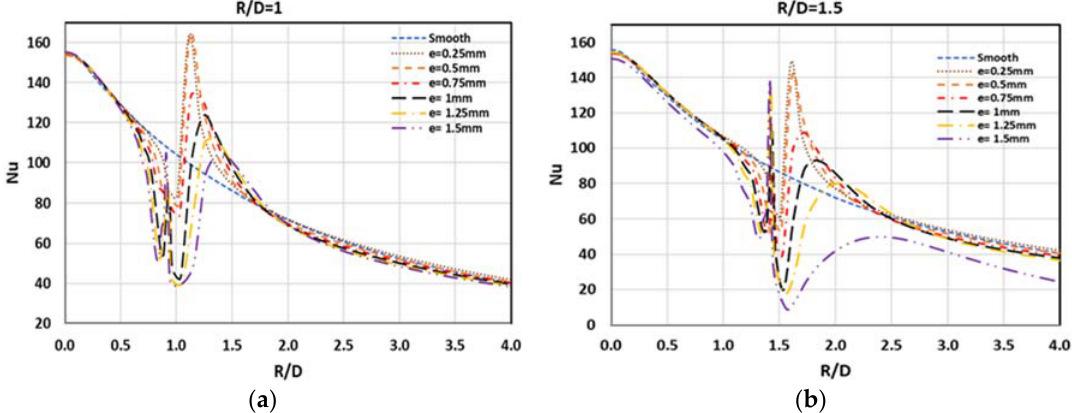
Figure 8. Local N (cid:2931) distributions for six rib heights e: ( a ) R/D = 1 and ( b ) R/D = 1.5. Figure 8. Local N u distributions for six rib heights e: ( a ) R/D = 1 and ( b ) R/D =